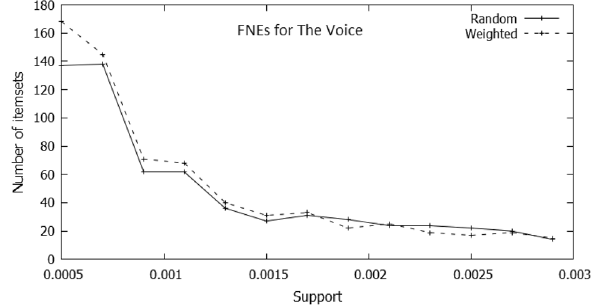
Fig. 7 Average number of itemsets for The Voice dataset